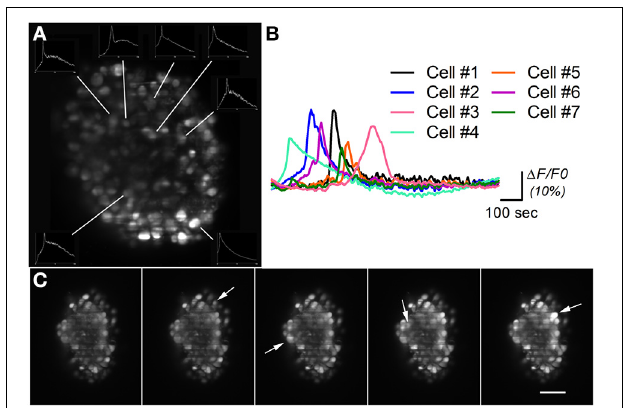
FIGURE 5 | Calcium imaging on differentiated neural aggregates stained with AM-ester calcium indicator. (A) Section of a neural aggregate with Ca 2 + oscillations (insets) (B) Normalized intensity of the Ca 2 + oscillations at seven different cells of neural aggregate in (A) imaged during 25min. (C) Five time points of a neural aggregate showing Ca 2 + oscillations in different cells (arrows). A time lapse movie is shown in Movie S3 . Scale bar: 50 μ